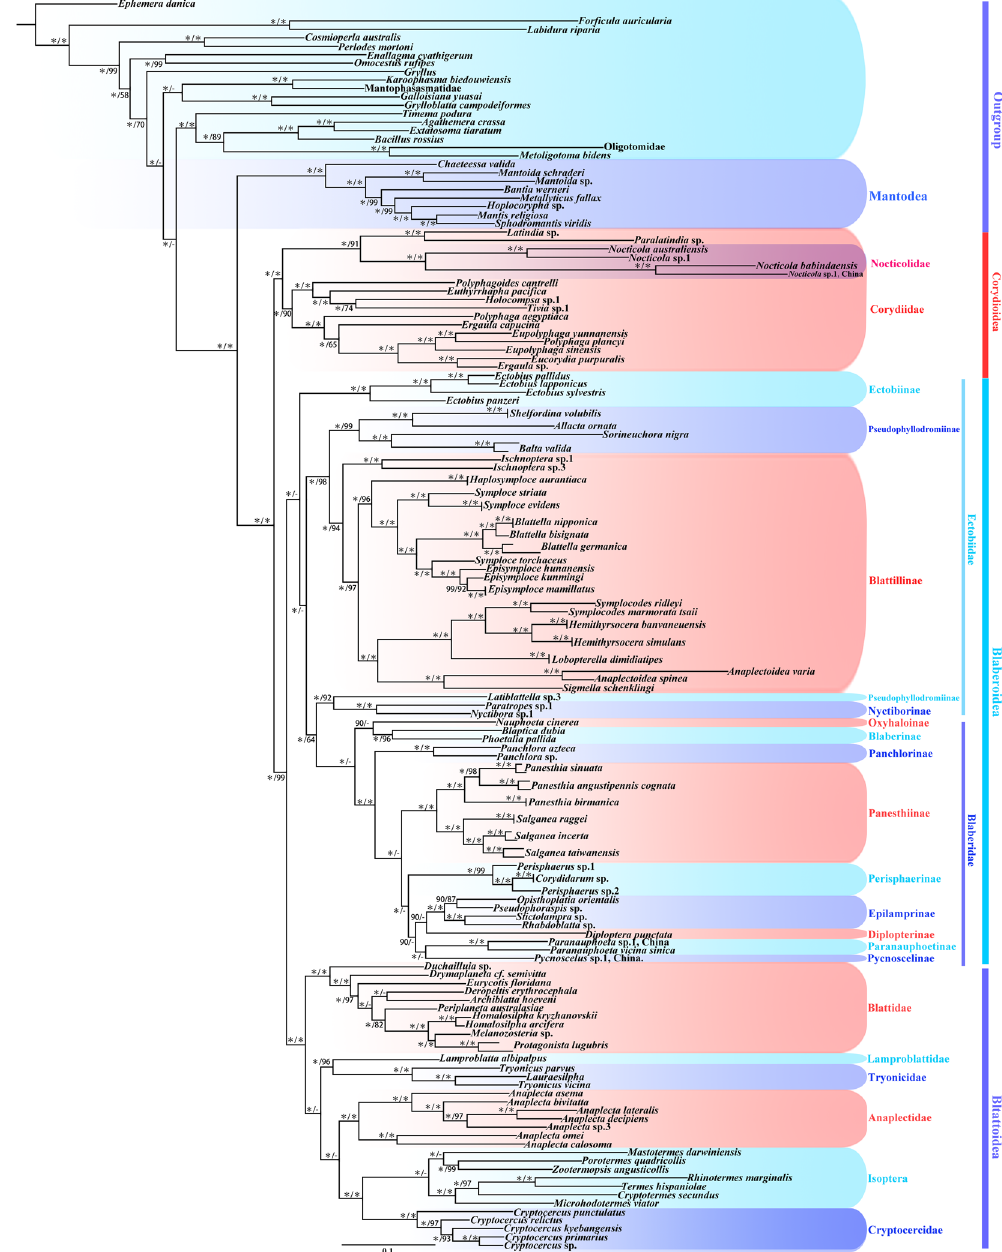
Figure 1. Maximum likelihood (ML) tree derived from analysis of combined data 12S rRNA, 16S rRNA, COII, 28S rRNA and H3 genes. Branch labels are support for our analyses in the following order: bootstrap supports of the maximum-likelihood tree, Bayesian posterior probabilities of the Bayesian tree; dashes (–) indicate that the node is absent for a given analysis; asterisks ( * ) indicate 100% support for a given analysis. The topology shown was very similar to that derived from BI analysis, with some minor differences (See Fig. S1). Note: Blattillinae =